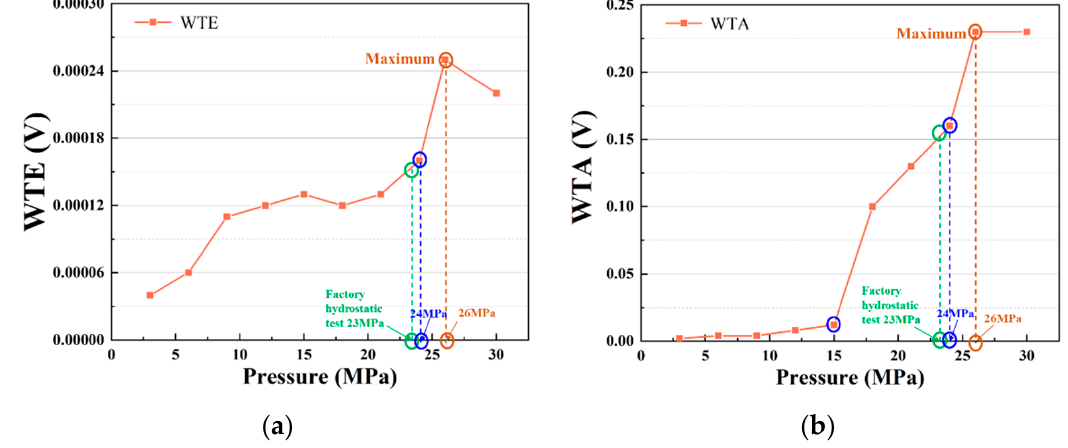
Figure 12. Correlation of fiber fracture characteristic parameters: WTE ( a ) and WTA load ( b ).